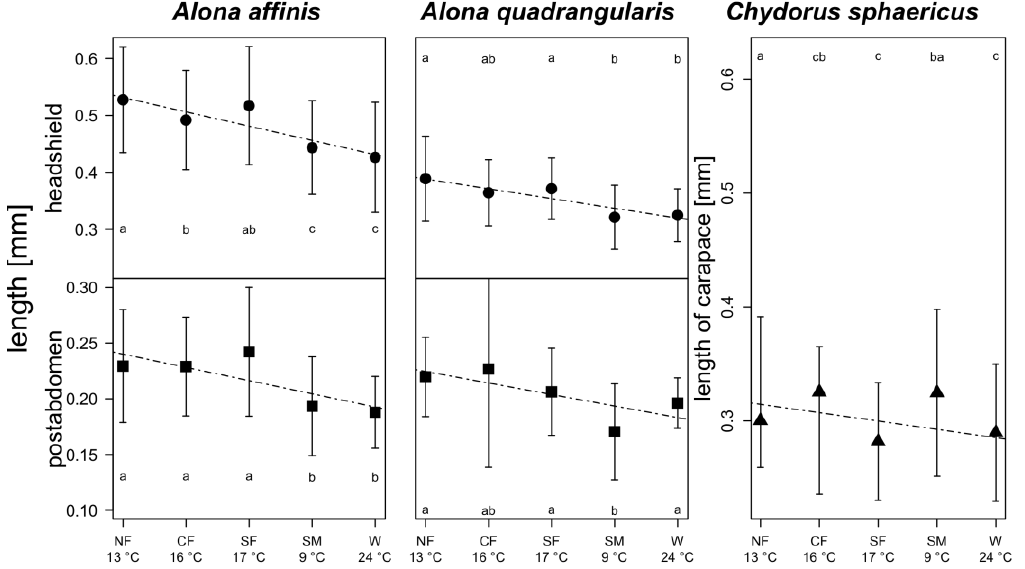
Figure A4. Distribution of mean lengths of headshields ( ⚫ ), postabdomens ( ◼ ) of Alona species and carapaces ( ▲ ) of Chydorus spharicus among subregions (NF: North of Finland, CF: Central of Finland, SF: South of Finland, SM: Southern mountain lakes, W: warm lakes; groups with the same letters are not distinguishable, whereas groups with different letters differ significantly).